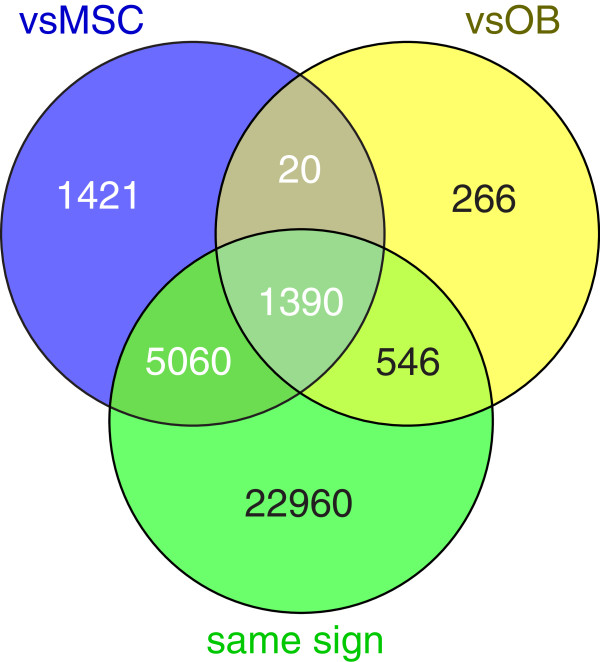
Intersection of top lists. Venn diagram showing the significant probes in the analysis of osteosarcoma cell lines vs MSC (vsMSC) and vs osteoblasts (vsOB), and the intersection of these significant probes with the subset of all probes (both significant and nonsignificant) that shows both up- or both downregulation in these two analyses (same sign). In total, 1,410 probes are significant in both analyses, of which 1,390 have the same sign of logFC.